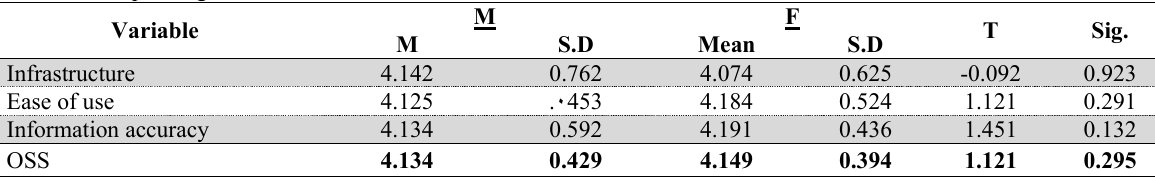
IST of OSS depending on